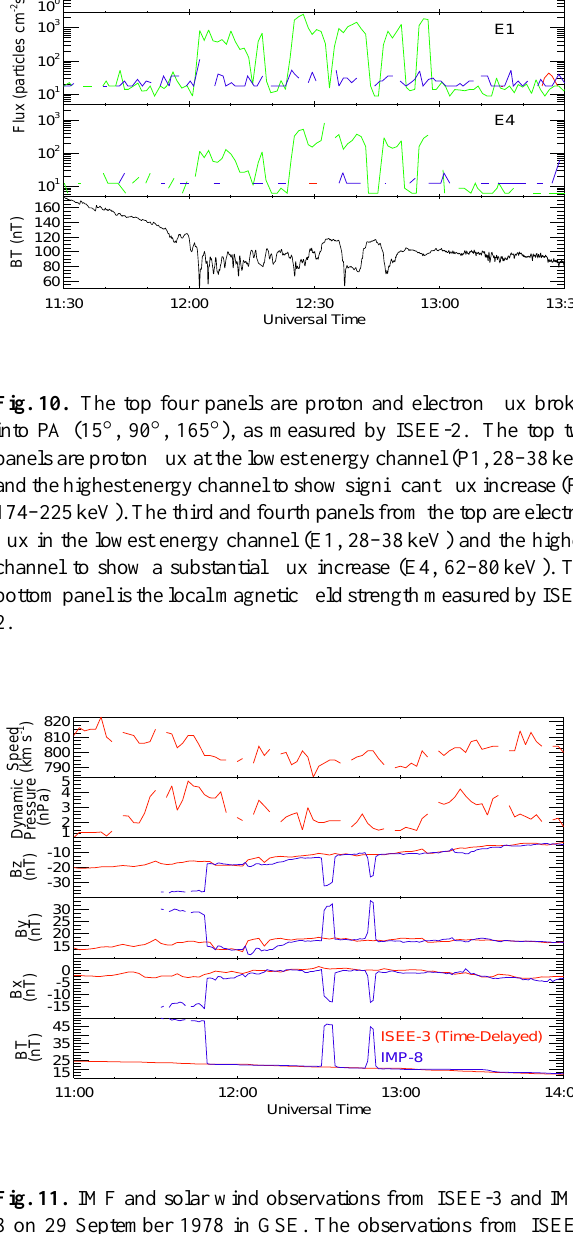
Fig. 11. IMF and solar wind observations from ISEE-3 and IMP- 8 on 29 September 1978 in GSE. The observations from ISEE-3 and IMP-8 have a time resolution of 2 and 1min, respectively. The data from ISEE-3 are delayed 27min, to account for the distance between the spacecraft. IMP-8 does not have solar wind speed data for this period, while the data points for ISEE-3 are due to data gaps (first and second panel from the top).